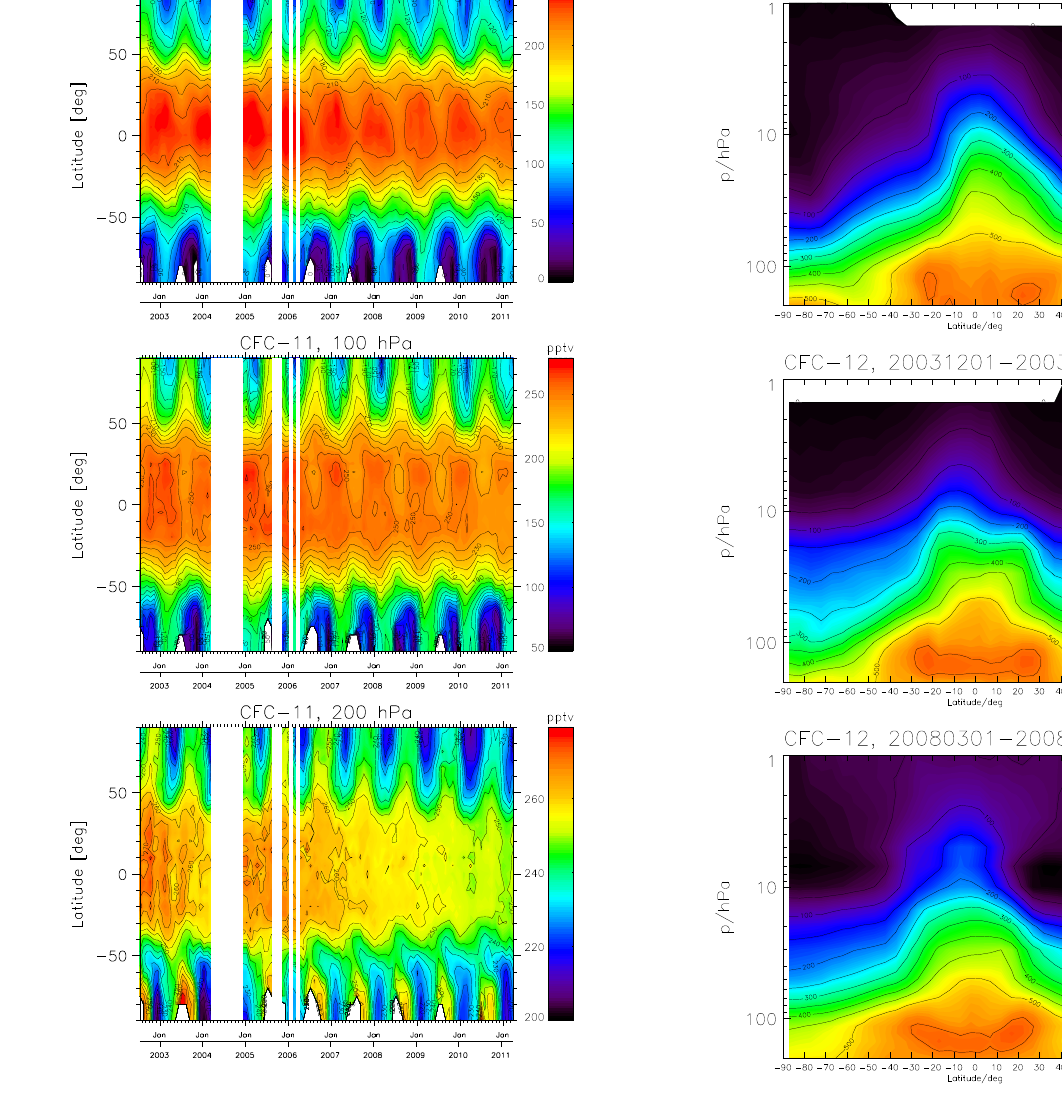
Fig. 9. Time series of CFC-12 as a function of latitude between July 2002 and April 2011 at 15 hPa, 20 hPa and 50 hPa. Details as for Figure 6. Fig. 8. CFC-12 monthly zonal mean distribution between 200hPa